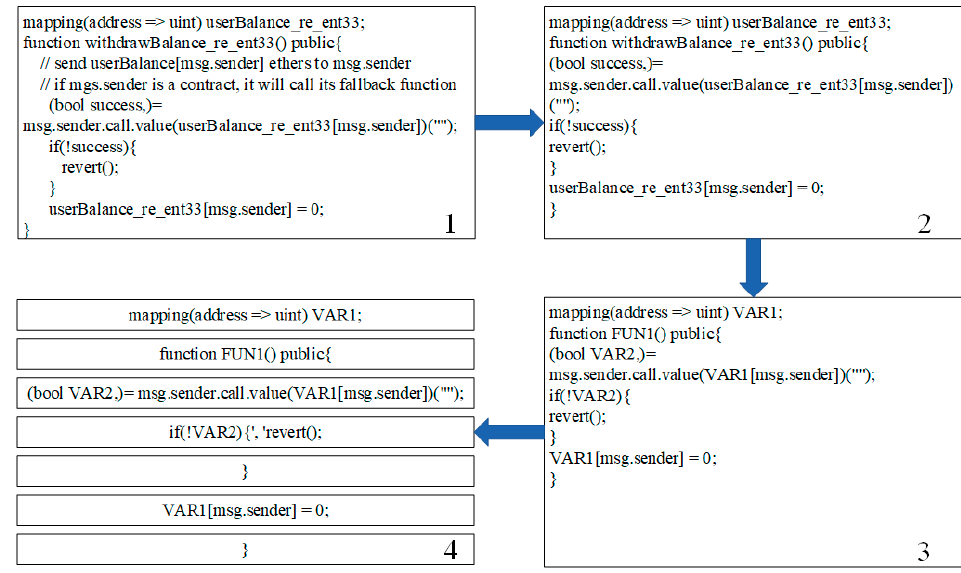
Figure 9. Smart Contract Processing One.